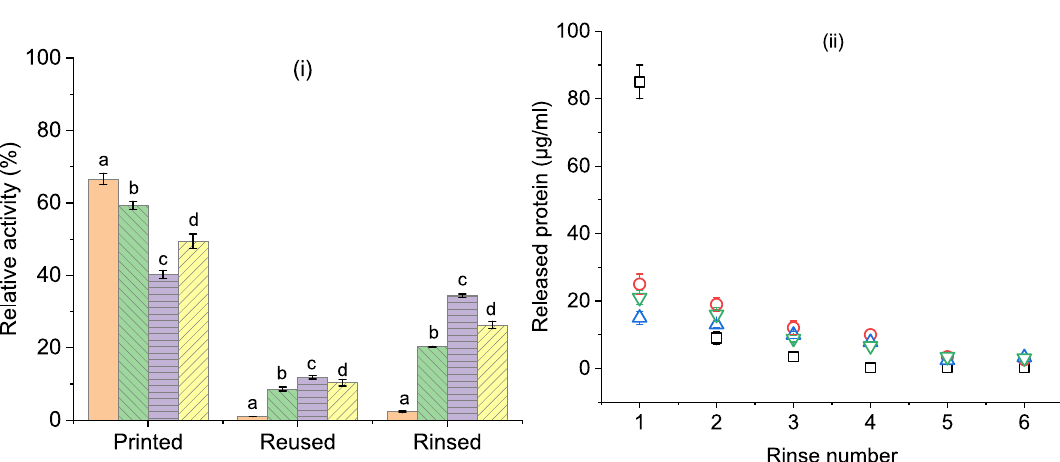
Figure 6. ( i ) Activity of tyrosinase printed on polyamide-6,6 fabrics (a) untreated and plasma-treated by (b) oxygen, (c) nitrogen and (d) mixture of oxygen and nitrogen gasses, remaining activity of the same fabrics upon one reuse and activity after six rinsing cycles in buffer solution. Results are presented as a percentage of the ink activity before printing (100% activity); ( ii ) Protein (tyrosinase) released in buffer solution upon several rinsing cycles from fabrics: untreated ( □ ) and plasma pretreated by oxygen (O), nitrogen (Δ) and the mixture of oxygen and nitrogen ( ∇ )